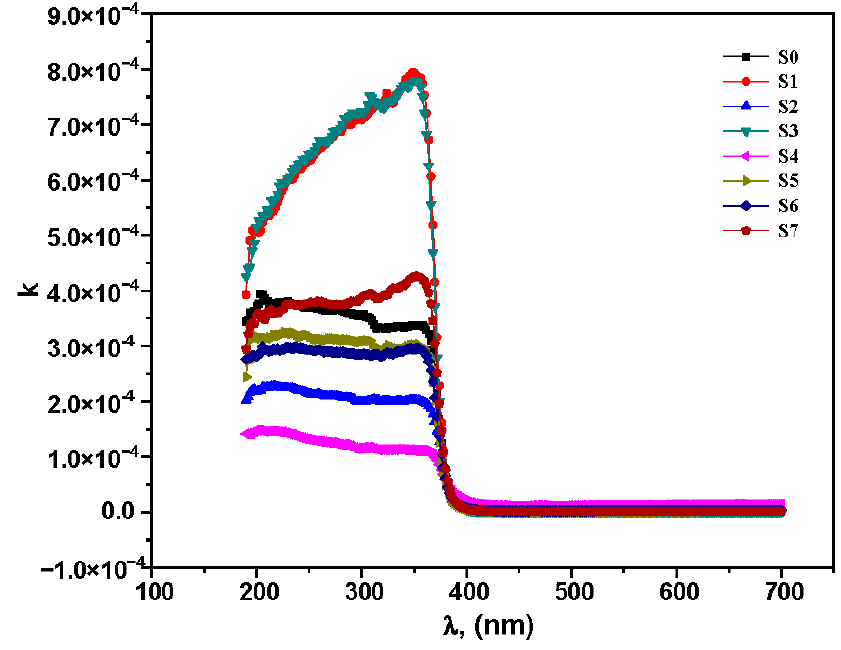
Figure 5. Graph the absorption coefficient (k) of the prepared Eu 2 O 3 -ZnO nanocomposites as a function of light wavelength between 200 nm and 700 nm.